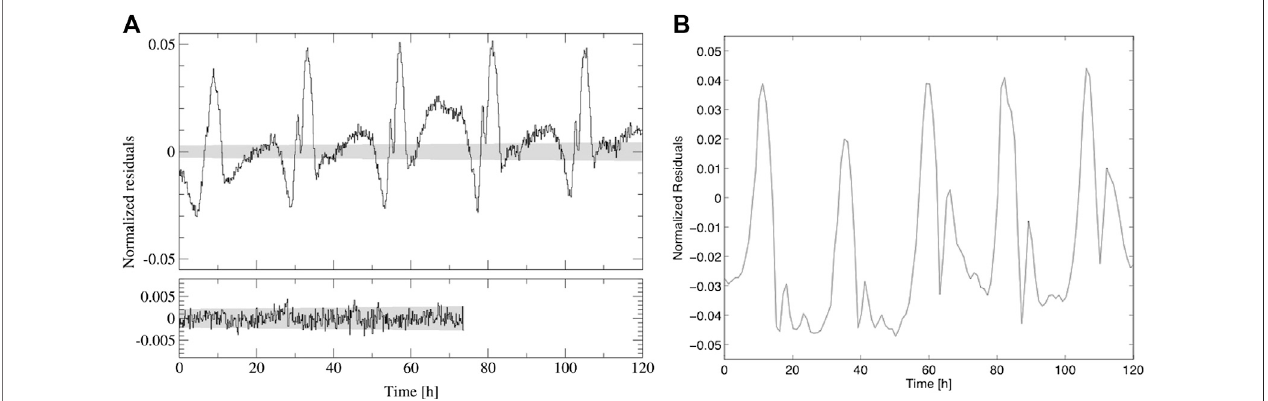
FIGURE2|(A) NormalizeddeviationsfromtheexponentialtrendofthemeasuredcountrateforradoninairmeasuredbyBellottietal.[15].Theupperpanelshows the data without polystyrene particles inside the glass sphere containing air charged with radon, the lower panel with these particles. Fluctuations within ± 2 σ are shown with shaded areas. Reprinted from Bellotti et al. [15] with permission from Elsevier. (B) A plot of a 120-h sample of the normalized hourly measurements of the gamma count rate registered by the GSI experiment ( Radon Decay Measurements Acquired at the Geological Survey of IsraelLaboratory ), showing a diurnal variation very similar to that shown in (A) .